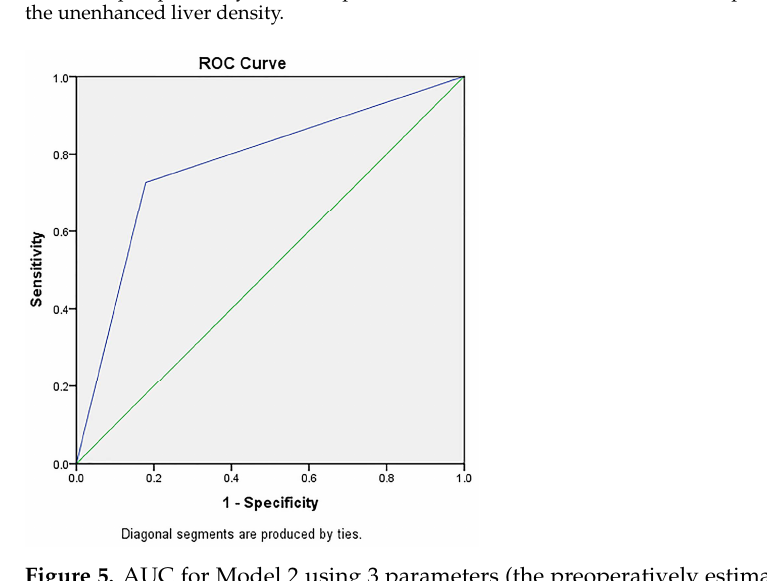
Table 5. Multivariate logistic regression for Model 2.